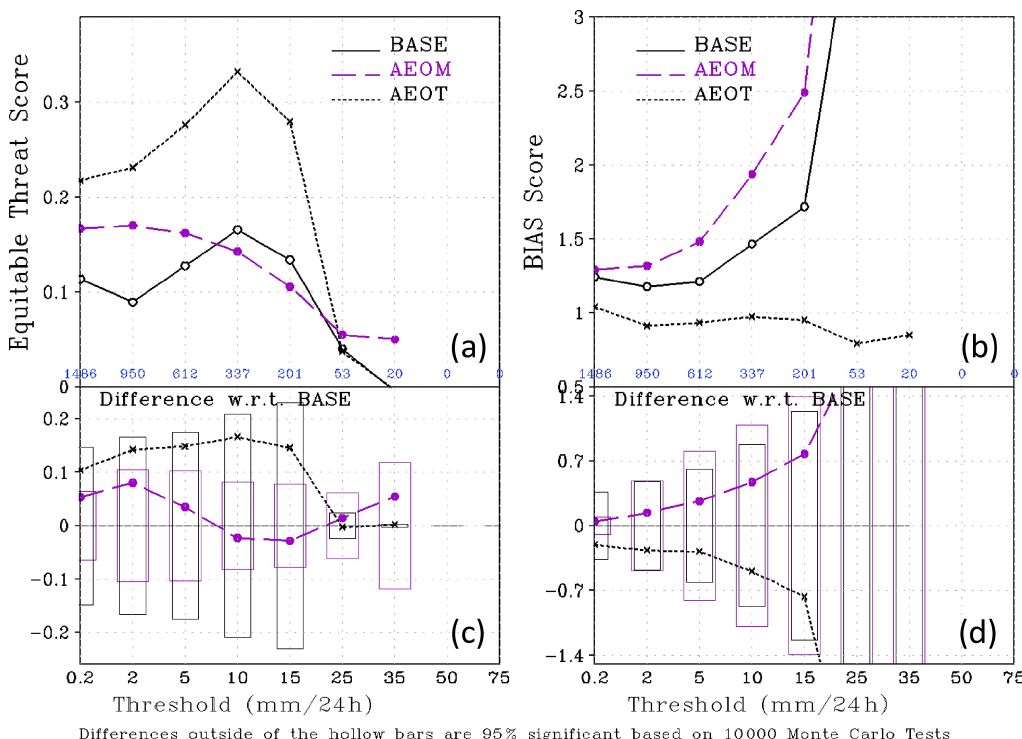
Figure 19. The forecast skill scores for 24h accumulated precipitation for 156 to 180h forecasts validated from 12:00UTC on 26–28 November 2019. The equitable threat (a) and bias score (b) are measures of the forecast skill for location and amount of precipitation, respectively. The differences relative to the BASE and the statistical significances are shown in panels (c) and (d) , respectively. The equitable threat and bias scores closer to 1.0 indicate improved precipitation forecast